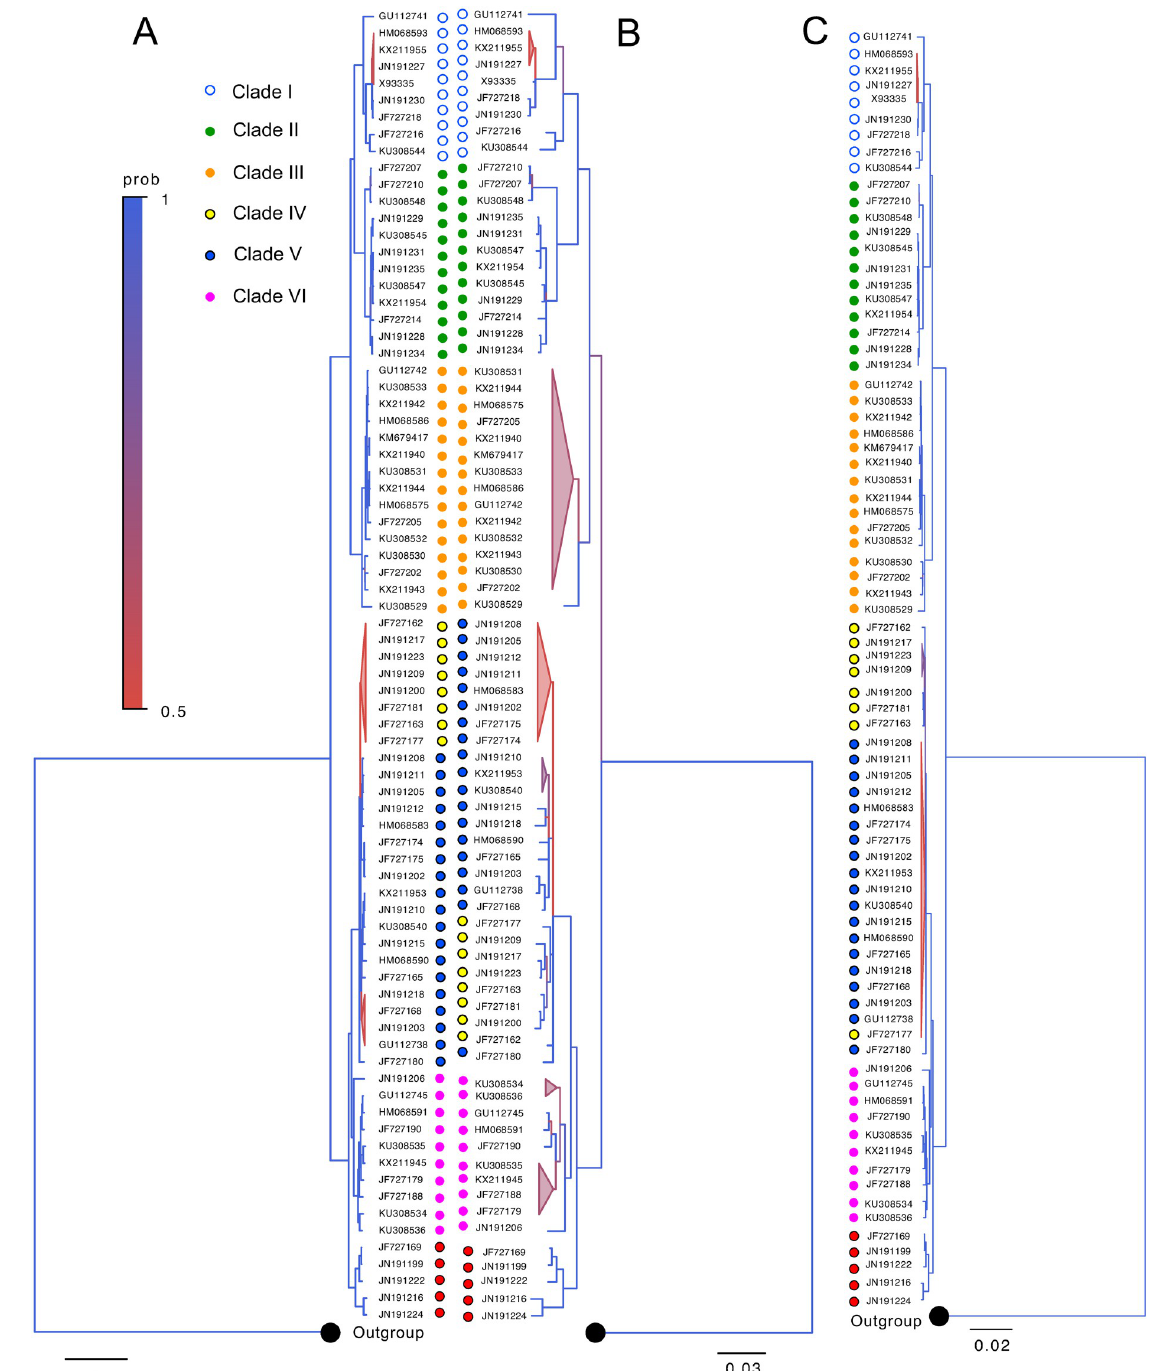
Fig 5. Phylogenetic divergence based on (A) full-length mtDNA and (B) cob and (C) contiguous sequence including cob to rnS of P . troglodytes . The phylogenetic trees were reconstructed and rooted with Gorilla gorilla gorilla an outgroup (NCBI accession NC 011120.1). Branches with a posterior probability of 0.5 to 1.0 are expressed in color as indicated. Each branch is color-coded by the clades in (A) as